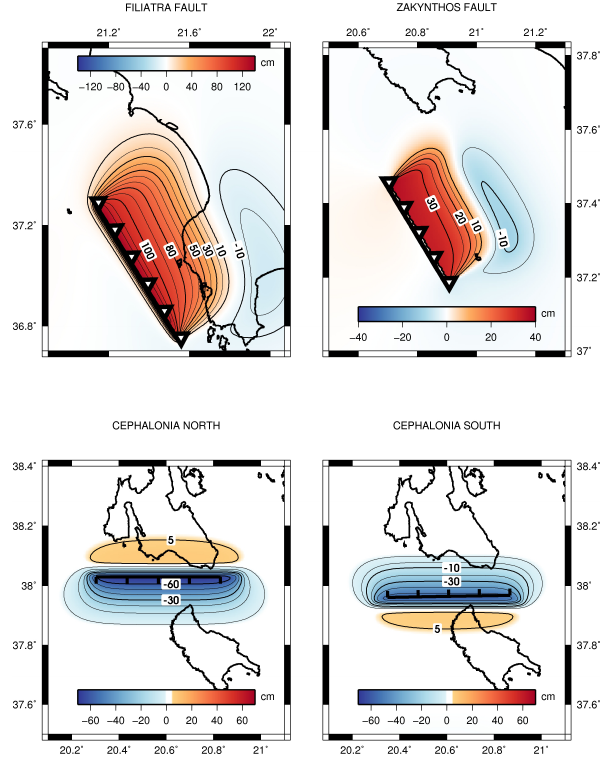
Fig. 2. Sea bottom expected displacements due to the activation of the four sources considering the source parameters depicted in Table 2.